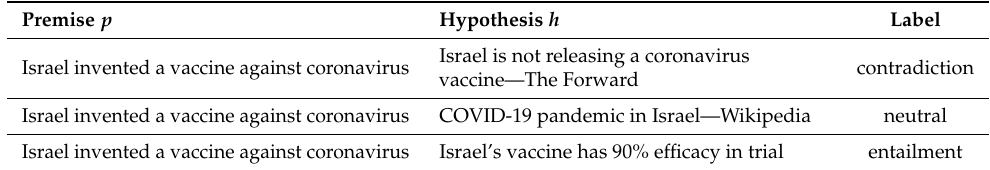
Table 3. Example of how the NLI model can be used to extract relations between